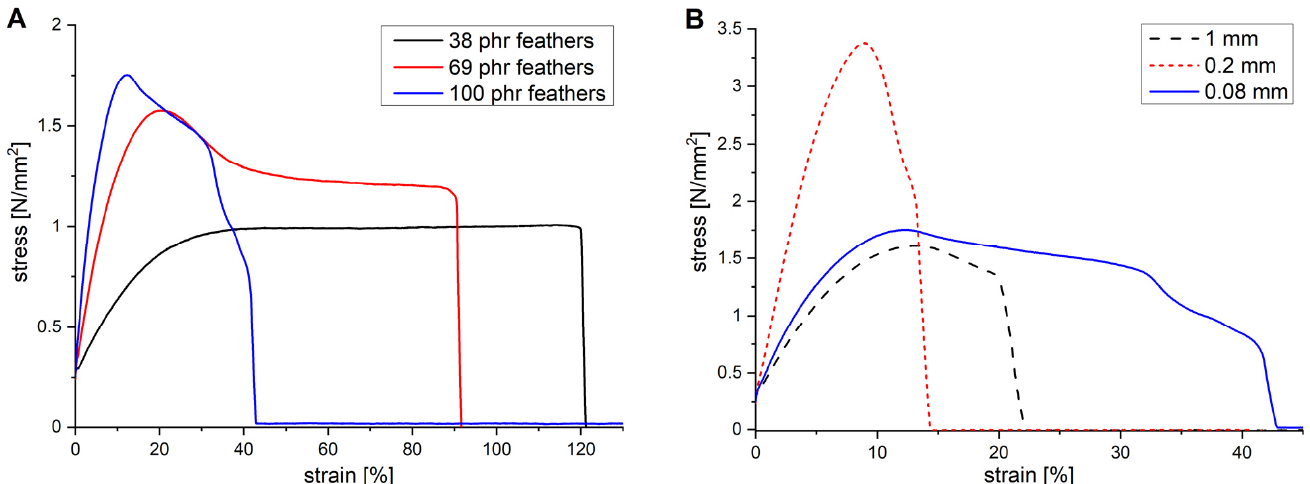
Figure 1. Stress–strain curves of the vulcanised EPDM mixture M1 filled with increasing amounts of 0.08 mm feathers cuttings ( A ) and with 100 phr feather cuttings of different length ( B ). Specimens were prepared from a single, 2 mm-thick sheet.